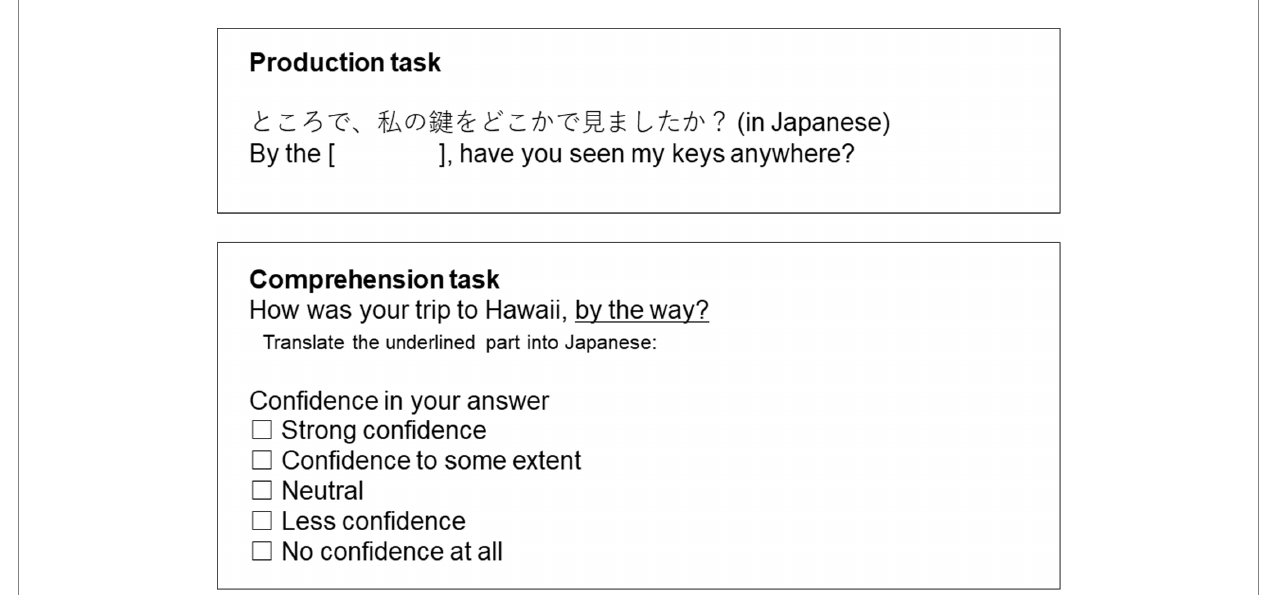
FIGURE 2 An example question from the screening task. The top includes an example question from the production task. The Japanese sentence corresponds to the English sentence. The bottom includes an example question from the comprehension task. The underlined word is the target phrase.